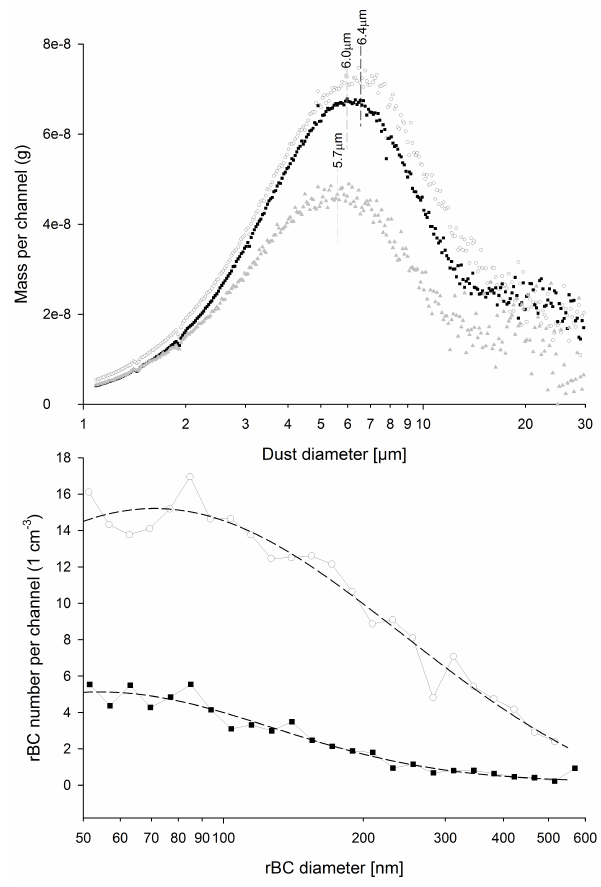
Figure 3. Dust and M rBC size distribution for the different seasons: inter-monsoon (empty circles), monsoon (black squares) and winter (gray triangles, for dust alone) and lognormal fit for M rBC distribu- tion (dashed